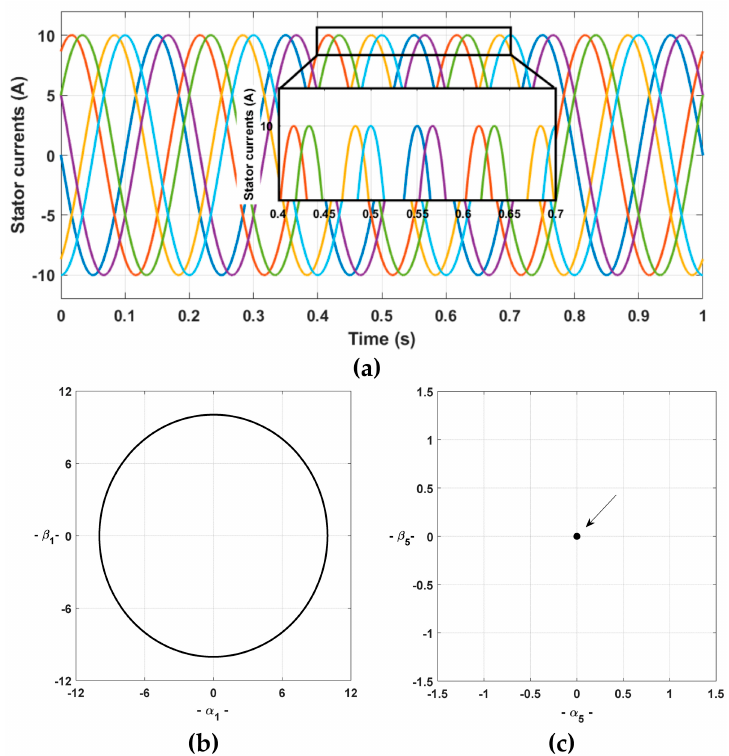
Figure 3. Simulation results: behavior of the drive using conventional field-oriented control (FOC), under healthy conditions: ( a ) stator currents waveforms, ( b ) current space vector in α 1 – β 1 plane and ( c ) current space vector in α 5 – β 5